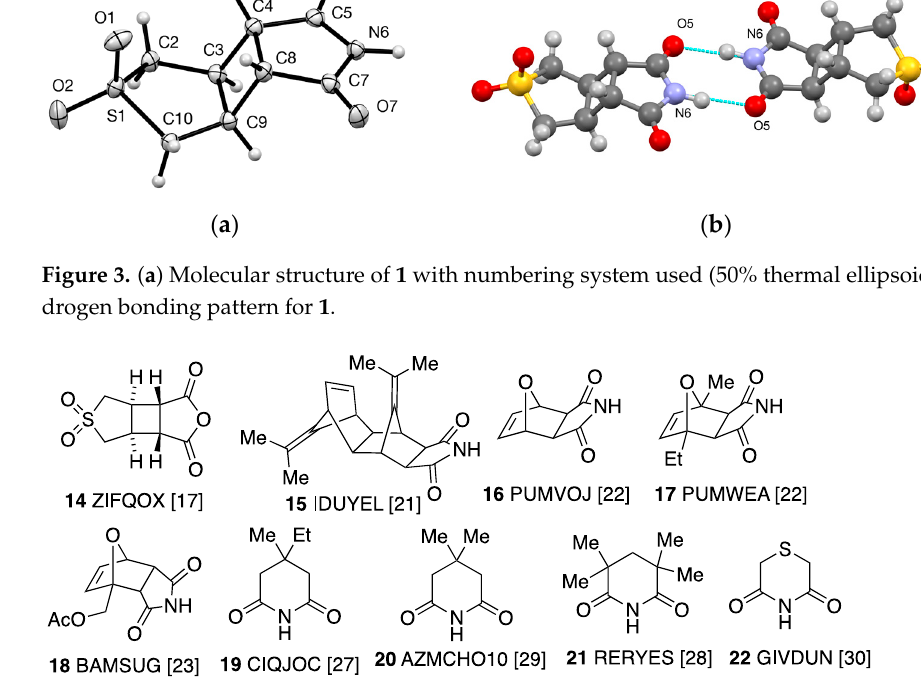
Figure 4. Structure of crystallographically characterised reference compounds 14–22 with CCDC Ref. Codes and literature references. Table 4. Hydrogen bonding parameters (Å, ◦